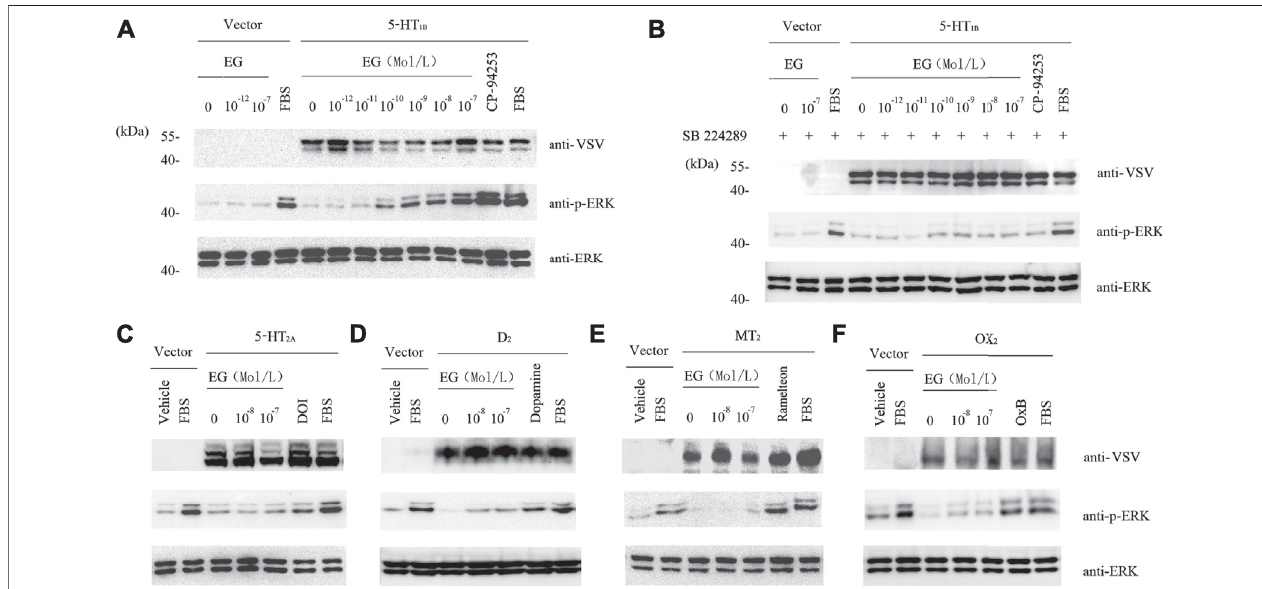
FIGURE 5 | EG selectively activates 5-HT 1B signaling. (A) Stable cell lines harboring inducible VSV-G-mGluR5-5HT 1B and corresponding vector constructs induced by 10 ng ml − 1 doxycycline for 12 h, and another 12 h of serum starvation for quiescence, then stimulated for 5 min by graded concentrations of EG (10 − 12 to 10 − 7 M in 5-HT 1B cells, 10 − 12 to 10 − 7 M in vector cells), and the 5-HT 1B selective agonist CP-94253 at 10 − 7 M, using FBS as positive control and deionized water as negative control. Samples were then subjected to western blotting. The expression of 5-HT 1B , phosphorylation of ERK1/2 MAP kinases and loading control of ERK1/2weredeterminedbyindicatedantibodies described aboveinlegendof Figure3 . (B) Stable celllinesand theinducing andstarvationtreatments weresimilar,as described in A above. Cells were pre-incubated with the 5-HT 1B selective antagonist SB 224289 at 10 − 7 M for 20 min, following stimulation and western blotting. (C − F) Stable cell lines harboring inducible VSV-G-mGluR5-5HT 2A (C) , VSV-G-mGluR5-D 2 (D) , VSV-G-mGluR5-MT 2 (E) , and VSV-G-mGluR5-OX 2 (F) and the corresponding vector constructs treated similar to A and the effects of EG on the indicated GPCR mediated pathways determined by phosphorylation of ERK1/2 MAP kinases. The induced and quiescent stable cell lines were stimulated for 5 min by graded concentrations of EG (10 − 8 and 10 − 7 M), and the selective agonis at 10 − 7 M, that were DOI, dopamine,ramelteonandOxB,respectivelycorrespondingto5HT 2A ,D 2 ,MT 2 and OX 2 cells, usingFBS aspositivecontroland deionized waterasnegative control. EG: emodin-8-O- β - D -glucopyranoside; FBS: fetalbovineserum; ERK: extracellular regulated protein kinases; CFP: cyan fl uorescent protein;5-HT 1B :serotonin receptor 1B; 5-HT 2A : serotonin receptor 2A; D 2 : dopamine receptor 2; MT 2 : melatonin receptor 2; OX 2 : orexin receptor 2; VSV: vesicular stomatitis virus; mGluR5: metabotropic glutamate receptor 5; FBS: fetal bovine serum; DOI (1-(4-iodo-2,5-dimethoxyphenyl) propan-2-amine; dopamine: 4-(2-Aminoethyl) benzene-1,2-diol; ramelteon (N-[2-[(8S)-2.6,7,8-tetrahydro-1H-cyclopenta [e] (Gadgaard and Jensen, 2020)